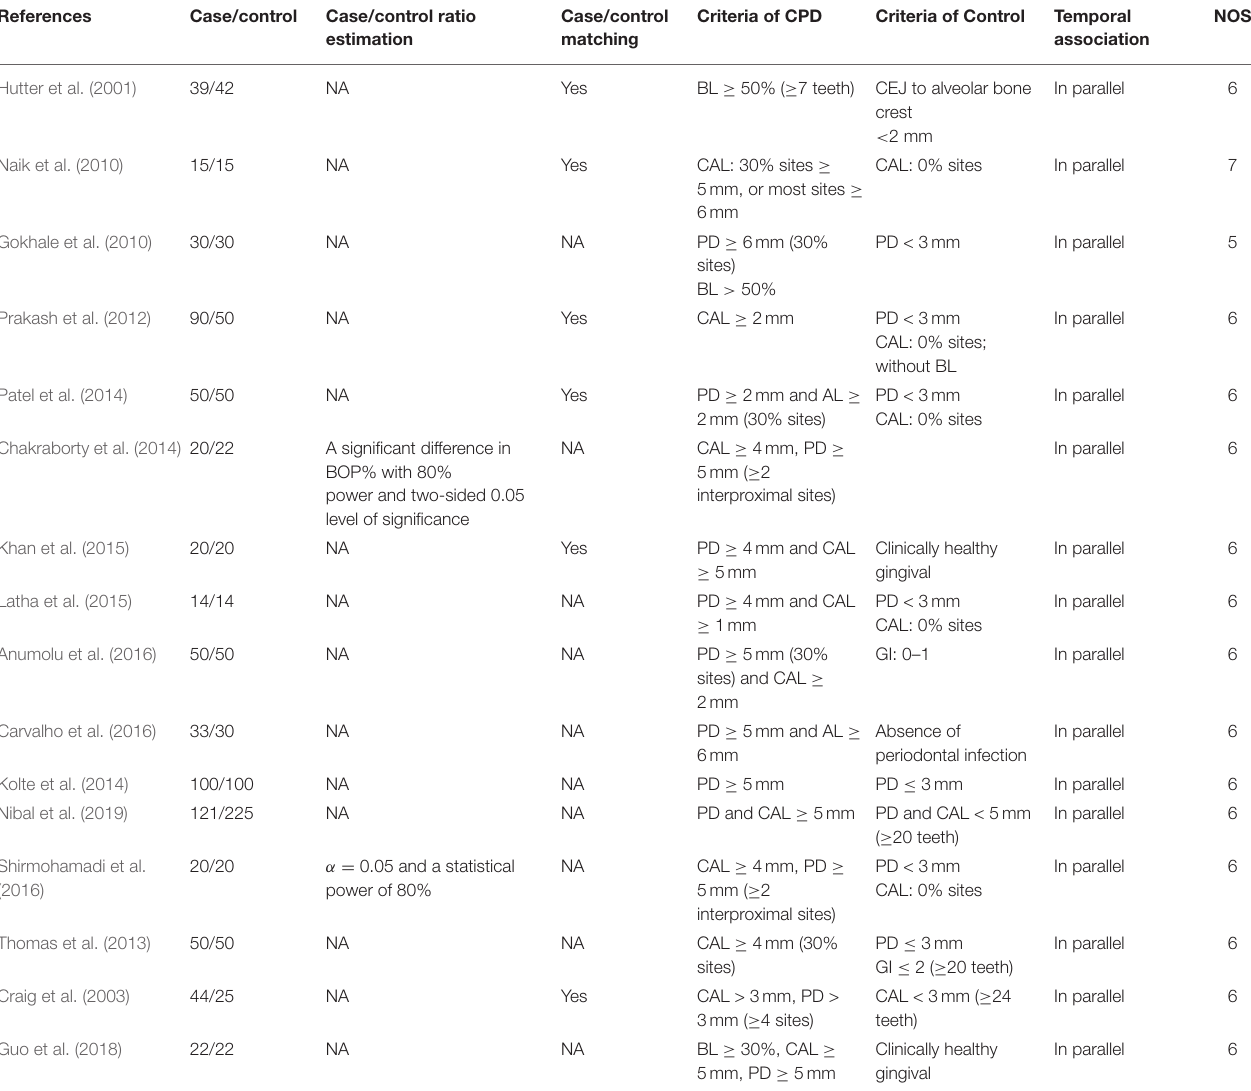
TABLE 1B | Characteristic of included